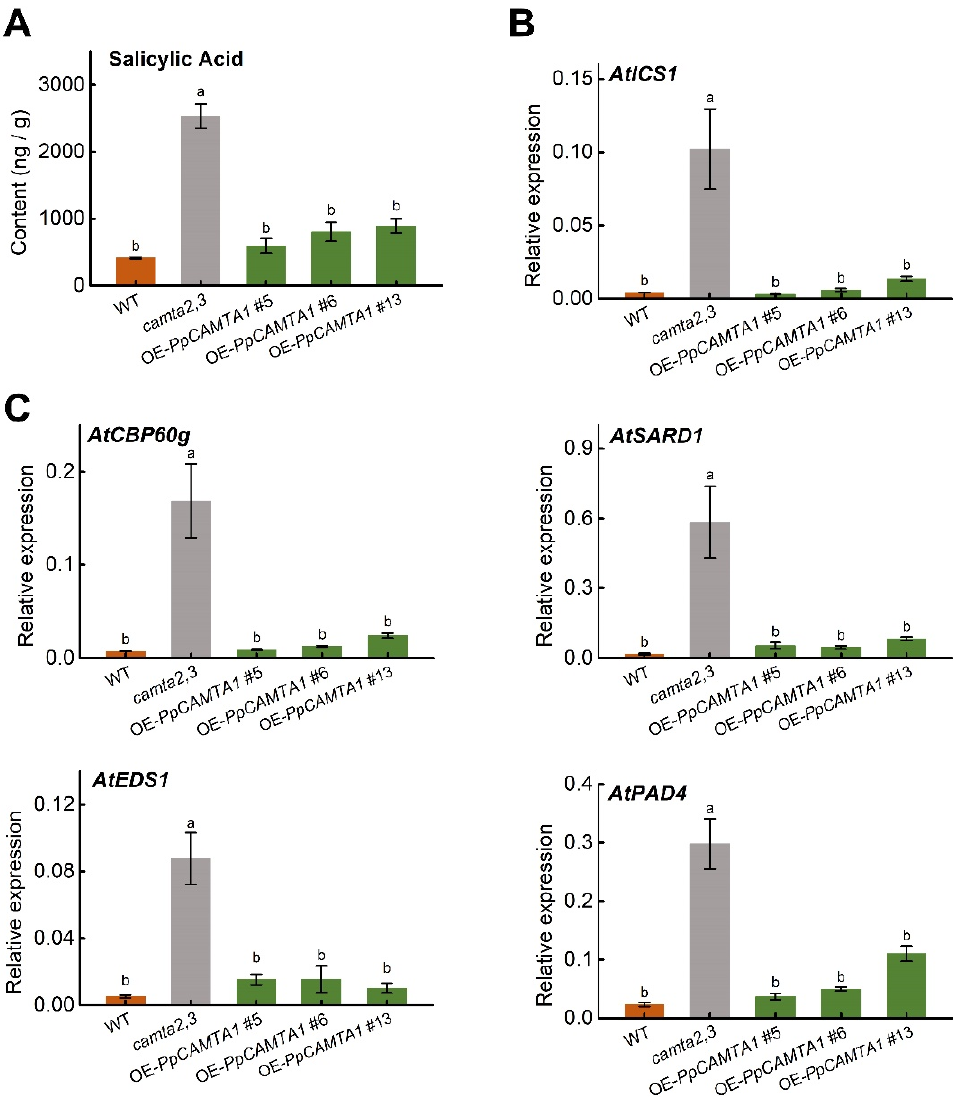
Figure 8. Overexpression of PpCAMTA1 in camta2,3 mutants inhibited SA level and SA pathway genes expression levels. ( A ) Free SA content in 4-week-old wild type, camta2,3 and OE- PpCAMTA1 plants. ( B ) Transcript levels for SA synthesis related gene AtICS1 . ( C ) Transcript levels for SA pathway transcription factors. Means and standard errors were calculated from three replicates. Different letters above the bars represent significant differences ( p <